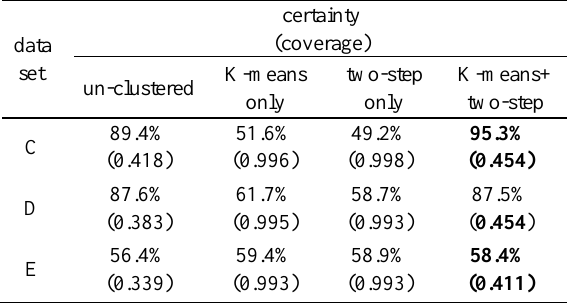
Table 13. A simple sensitivity study to evaluate the effect of the clustering